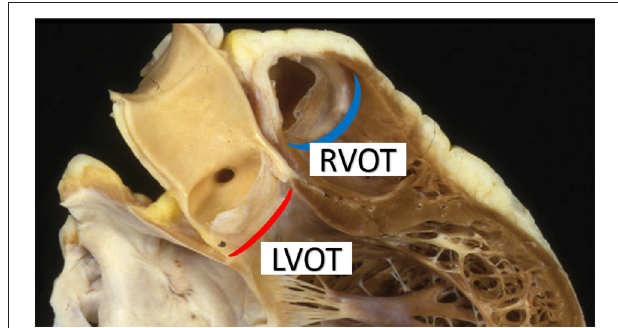
FIGURE 4 | The aortic annulus (red crescent) is embedded within the fibrous skeleton of the heart whereas the pulmonary annulus (blue crescent) consists of a freestanding rim of infundibular muscle lifting the pulmonary leaflets away from the interventricular septum. LVOT, left ventricular outflow tract; RVOT, right ventricular outflow tract. Figure adapted with permission from Ho